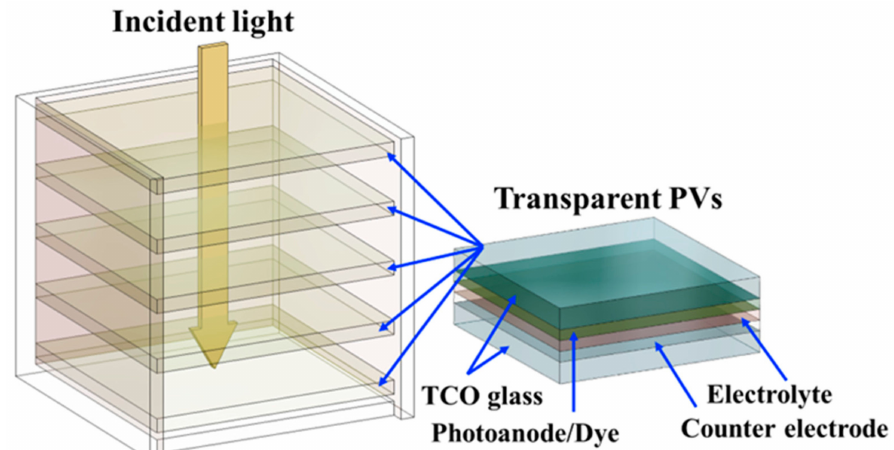
Figure 9. Schematic of 3D solar harvesting photovoltaic system with transparent PV